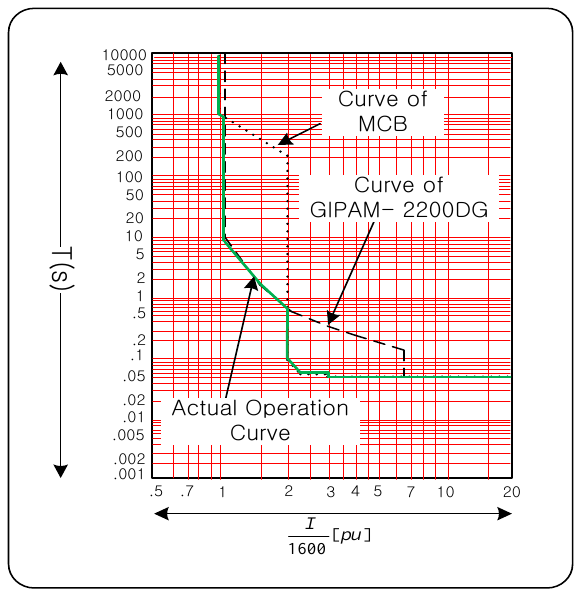
Figure 3. Present coordination curve of OCR for generator.